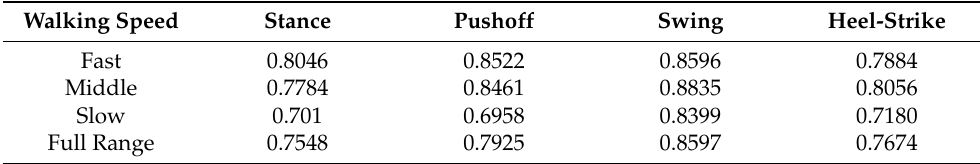
Table 8. Detailed results of gait phase recognition with different walking speed types given in F-measure